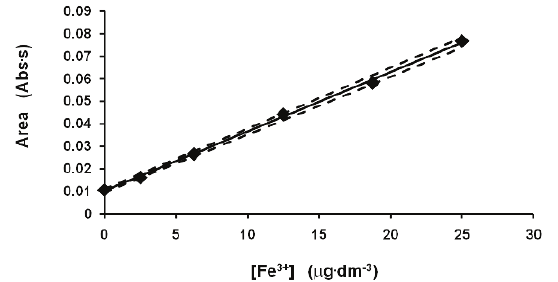
Figure 1. Data of determination of iron by Zeeman GFAAS shown together with the appropriate regression line (full line) and lines representing confidence ranges (95% level of confidence, p < 0.05). The slope of the regression line is 0.00263(3) abs s µg -1 dm 3 and the intercept is 0.0103(4) abs